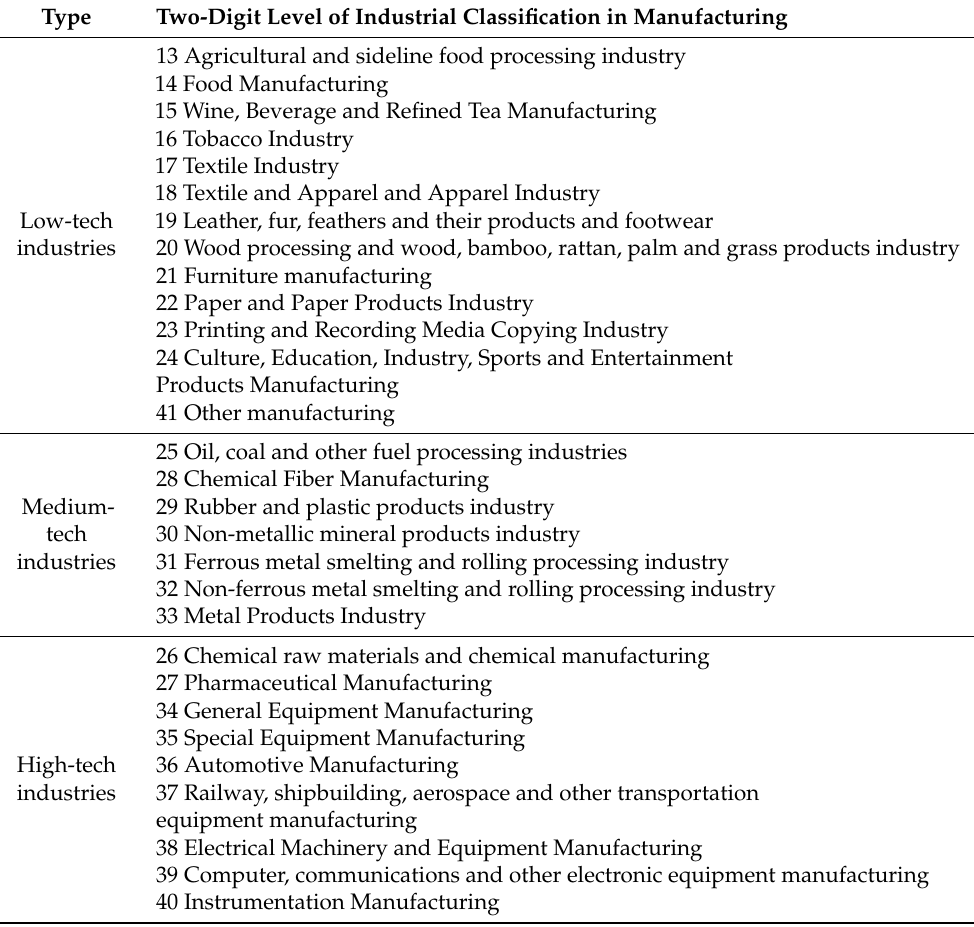
Table A1. Specific industries covered by different